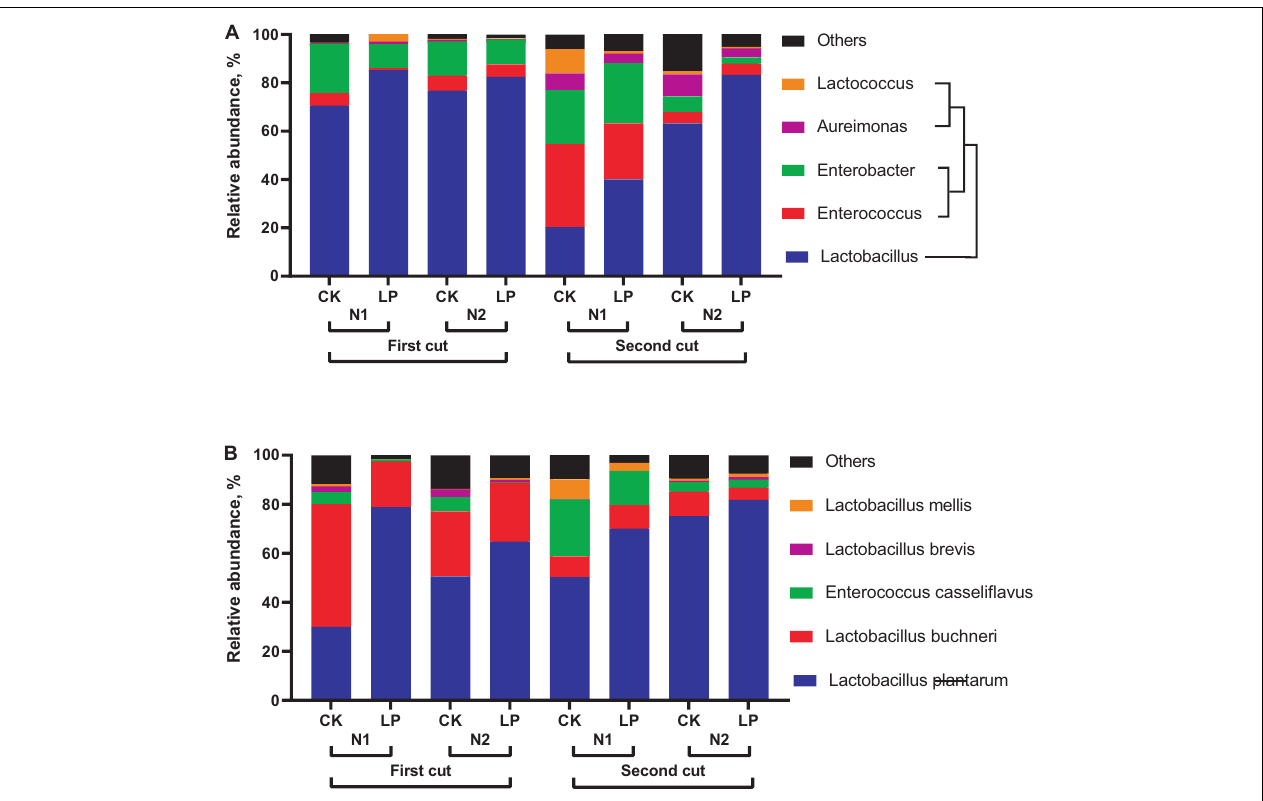
FIGURE 2 | Relative abundance of top five genera (A) and species (B) in silage treated without (CK) or with Lactobacillus plantarum (LP). Application of N fertilizations during cultivation was N1 (390 kg/ha/year) and N2 (485 kg/ha/year).